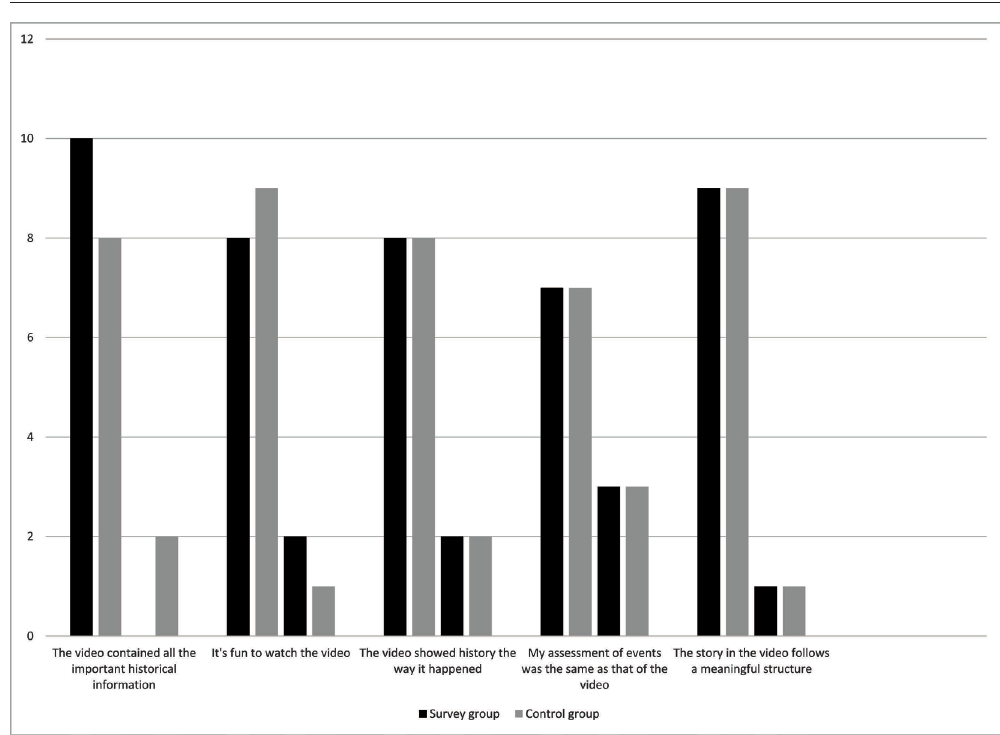
Figure 1: Evaluation of the ‘manipulated‘ video by survey group and control group